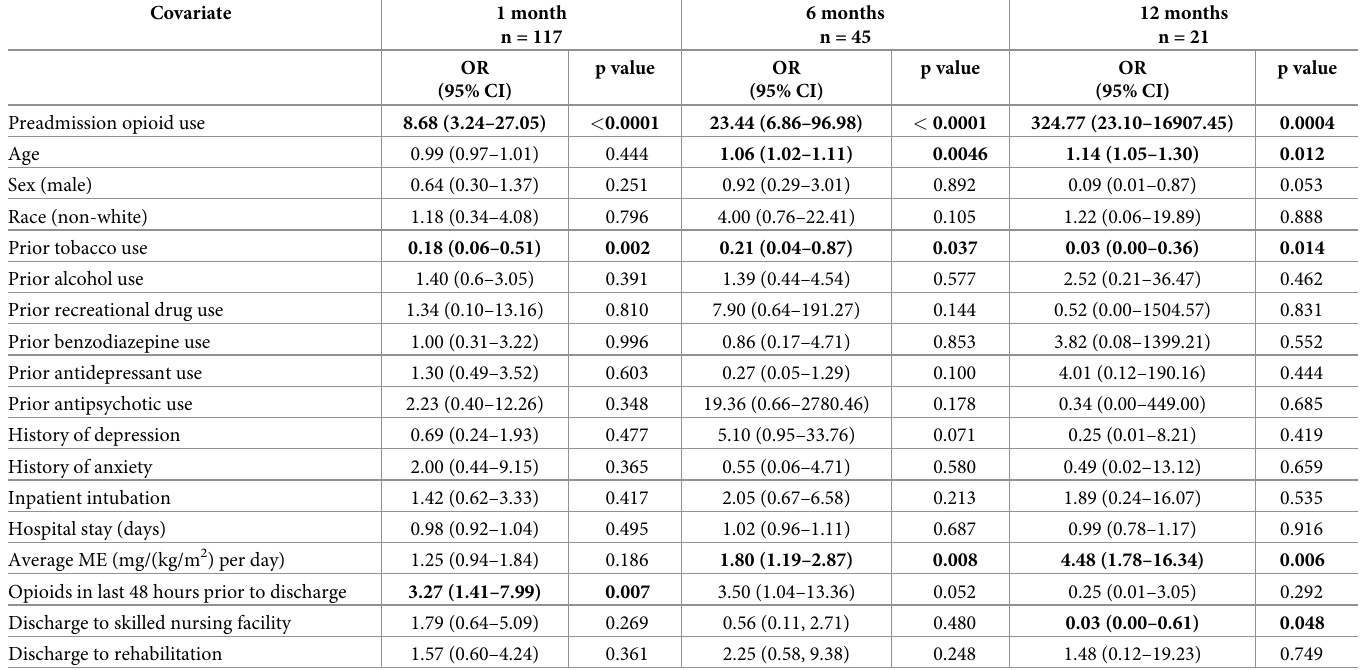
Table 3. Generalized linear model comparing odds of remaining on opioids after discharge between preadmission opioid users and naive opioid patients. Covariate